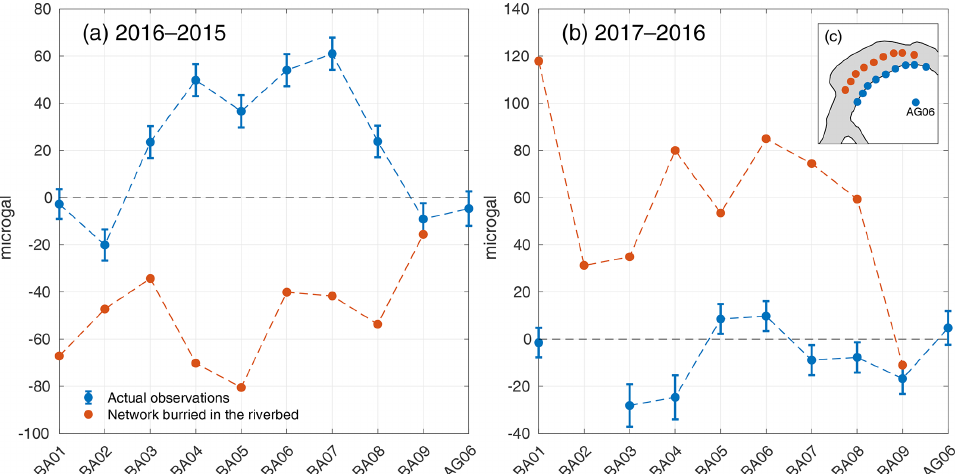
Figure 11. Gravity changes expected at new sites located 5m beneath the river (red), compared with those measured at BA01–BA09 (blue), for the same sediment mass redistributions as (a) between 2015 and 2016 and (b) between 2016 and 2017. The new sites are in fact BA01– BA09 translated 140m in the northeast direction, as illustrated in (c)